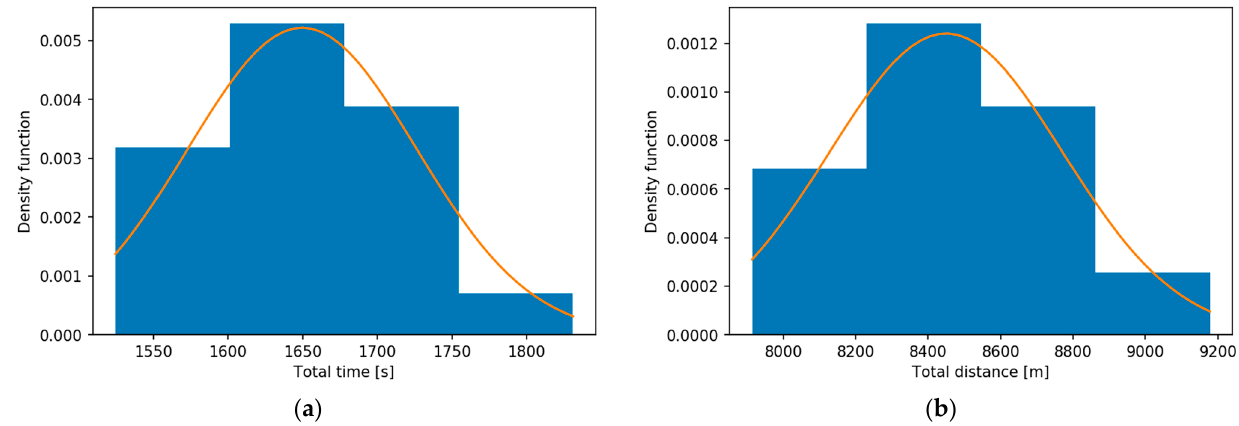
Figure 6. Histograms for all CVRP routes according to time ( a ) and distance ( b ).